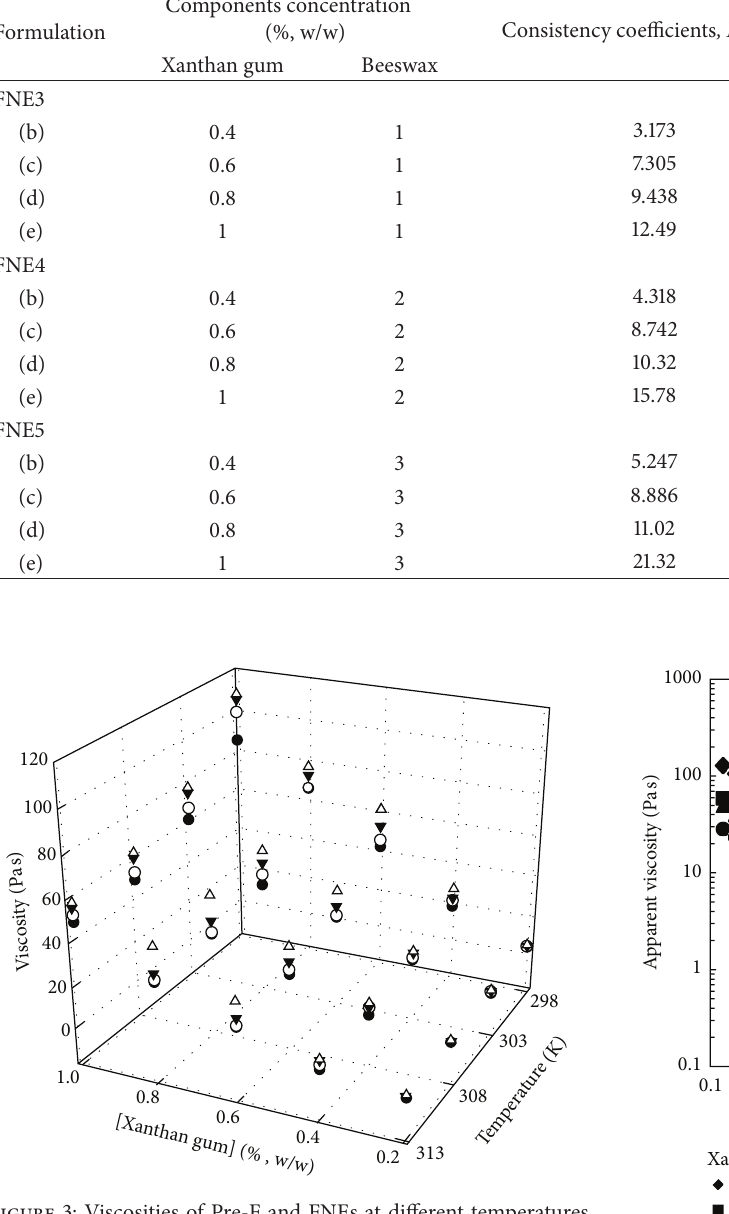
Figure 3: Viscosities of Pre-F and FNEs at different temperatures with varying concentration of xanthan gum containing 0% ( e ), 1% ( I ), 2% ( 󳶃 ), and 3% ( Δ ) of beeswax. Figure 4: Shear rate dependence of steady shear viscosity for FNEs with 1% (w/w) of beeswax with different xanthan gum